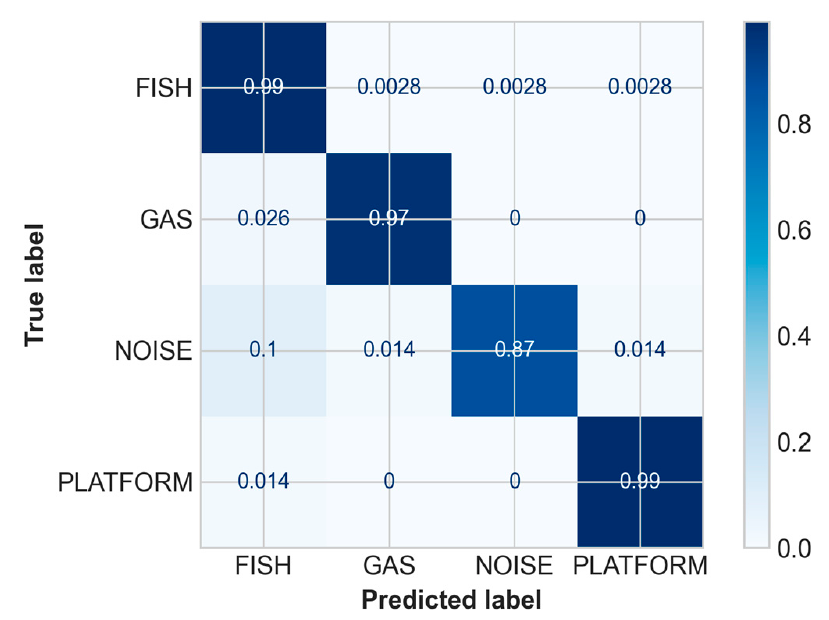
Figure 12. Confusion matrix of the ensemble model.